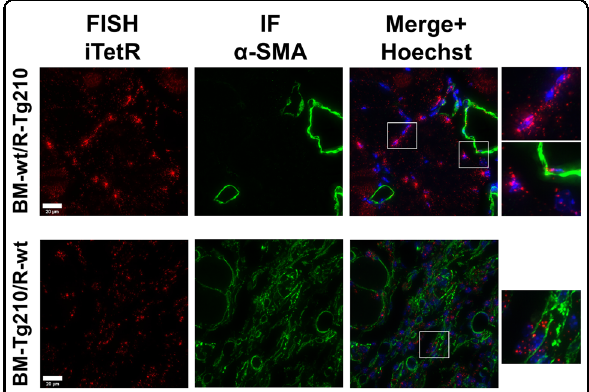
Fig. 5 α -SMA expression by BM-derived Tg-210 in fl ammatory cells. Representative images of double immuno fl uorescence staining for iTetR in situ hybridization (left, red), α -SMA (center, green) and merge (right) of ischemic gastrocnemius muscles sections of BM-wt/R- Tg210 mice and BM-Tg210/R-wt. Nuclei were stained by Hoechst (Blue). iTetR mRNA displays both nuclear and perinuclear staining. Representative images are presented as Maxprojections. Magni fi cation 63 × 0.5, calibration bar 20 µm.